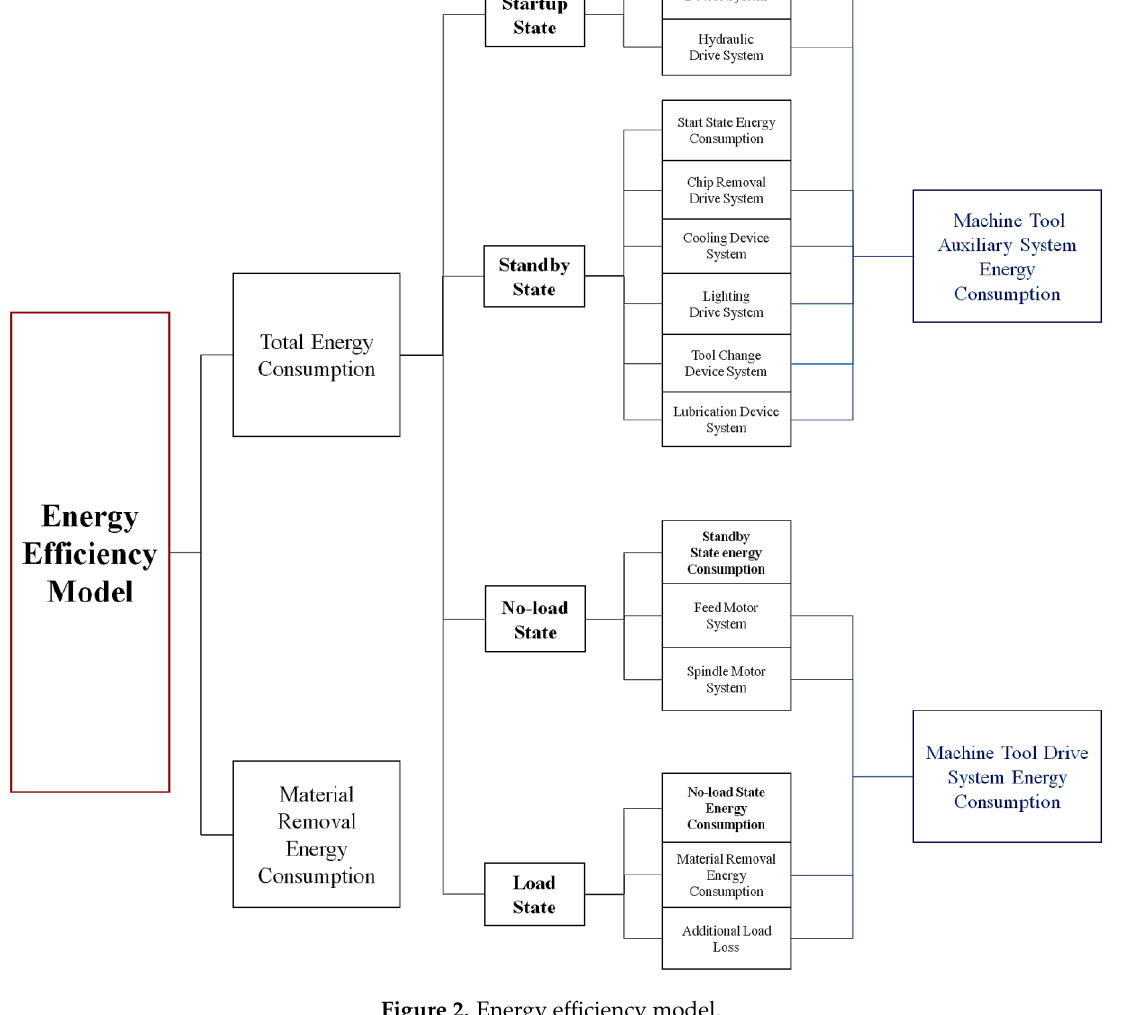
Figure 2. Energy efficiency model.